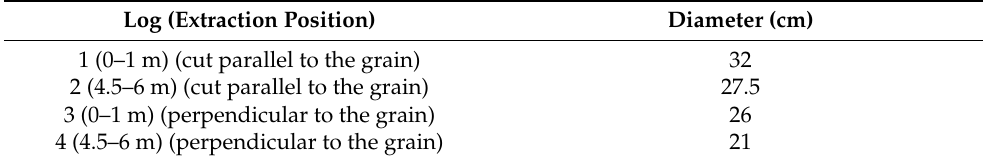
Table 1. Diameters of Paulownia logs depending on stem height.